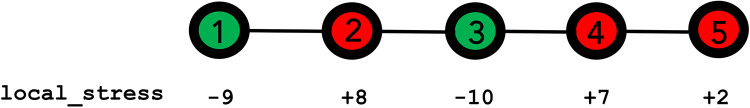
Cartoon of a simple chain graph where some nodes require to load share and a trivial majority heuristic rule provides a suboptimal solution.